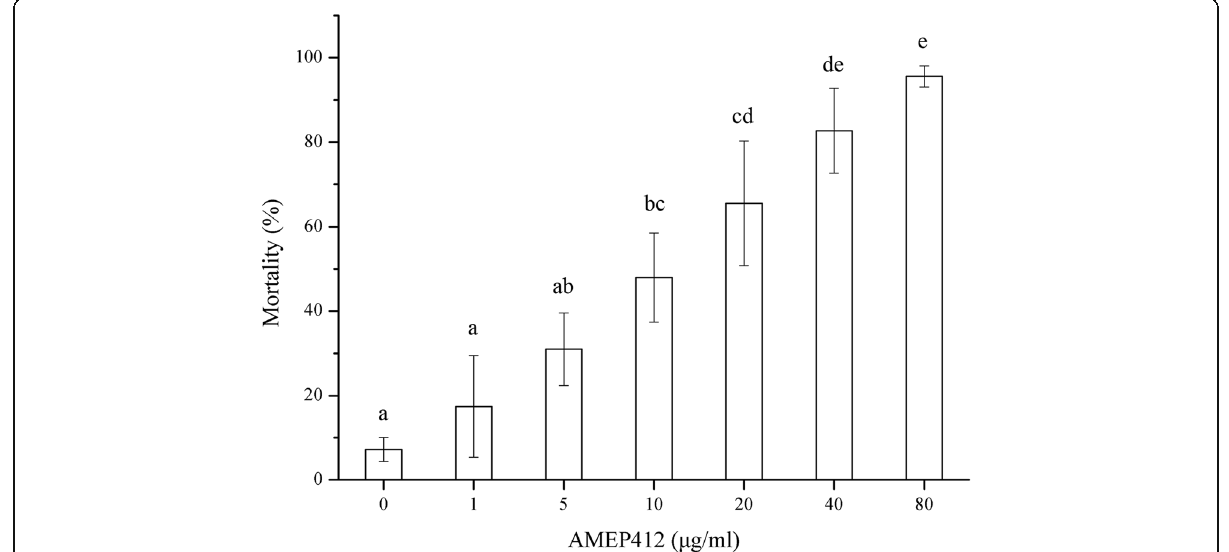
Fig. 1 Mortality of Bemisia tabaci adults fed on different concentrations of AMEP412. Means compared using Tukey ’ s HSD test at α = 5%; means superscripted with the same letter within a column are not significantly